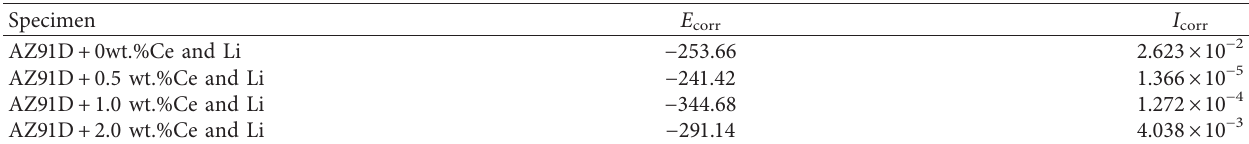
Table 3: Potentio dynamic polarization